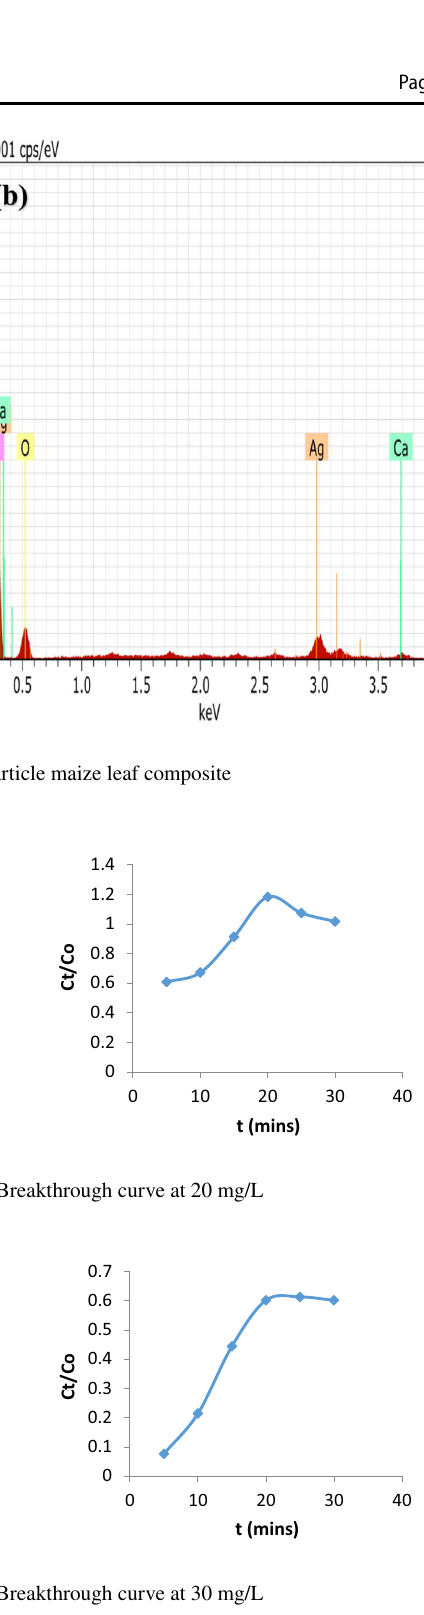
Fig. 4 Breakthrough curve at 30